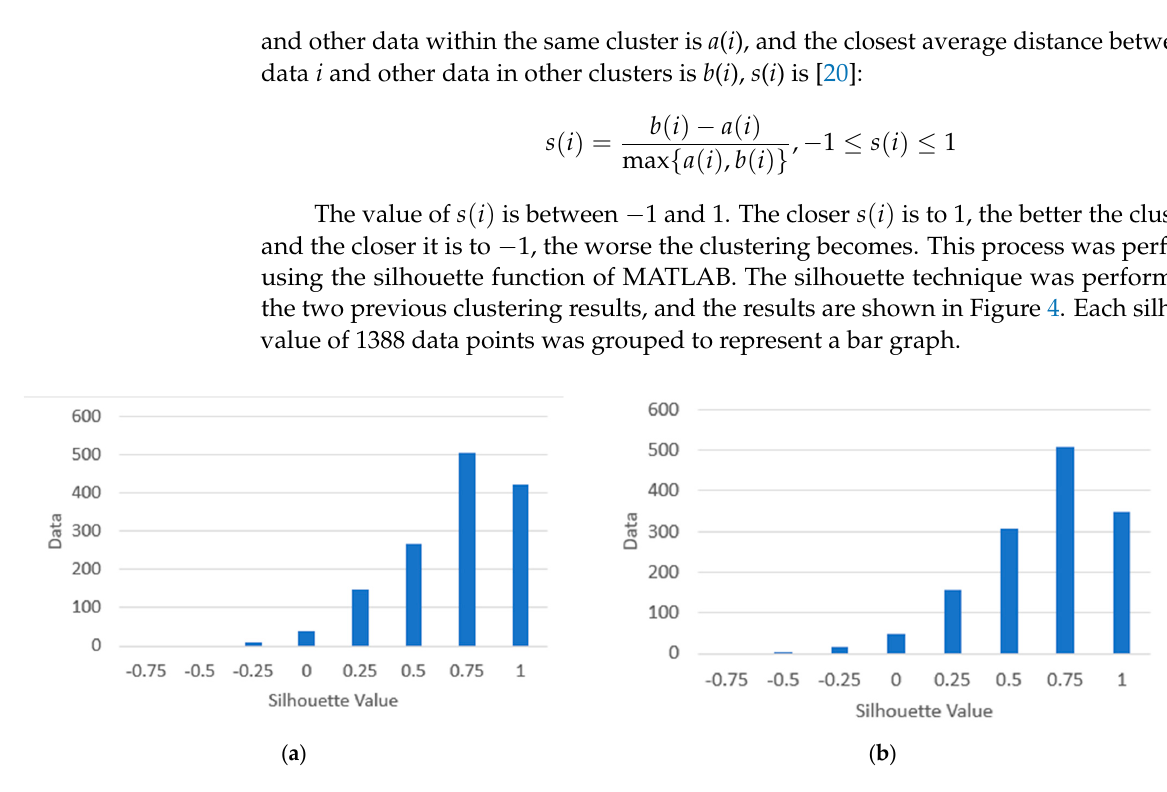
Figure 5. Seoul metropolitan area green belt.